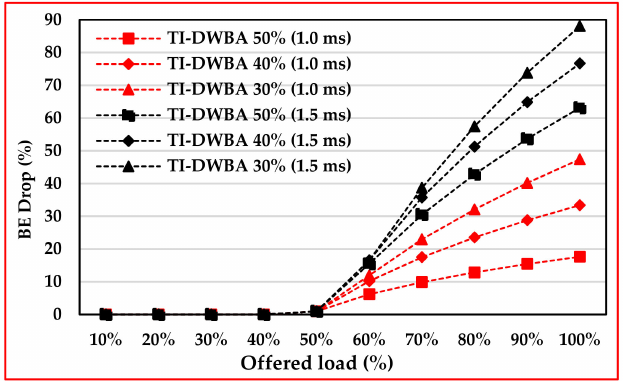
Figure 10. BE packet drop in cycle time 1.0 (ms) and 1.5